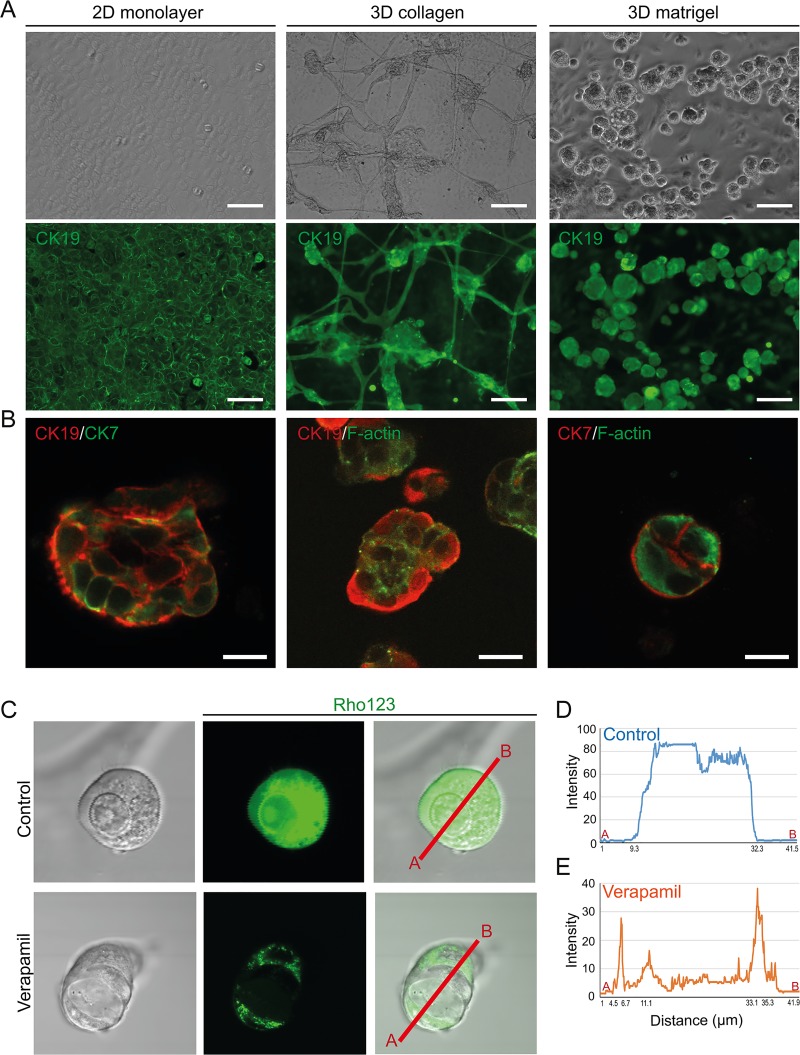
Characterization of iHepSC derived-cholangiocyte-like cells (iHepSC-CLCs).(A) Phase- contrast images of iHepSC-CLCs in different culture conditions (upper panel). Immunofluorescence images of iHepSC-CLCs stained with antibody against Cytokeratin19 (Ck19) (lower panel). Images of iHepSC-CLCs on 2D culture (left column). The tubule-like structure of iHepSC-CLCs cultured in the 3D collagen gel (middle column). The Cyst-like structure of iHepSC-CLCs cultured in the 3D Matrigel (right column). Scale bar: 150 μm. (B) Immunofluorescence analysis of iHepSC-CLCs co-stained with cholangiocyte specific markers, Ck19 and Cytokeratin7 (Ck7). Localization of F-actin (phalloidin) in the apical region of iHepSC-CLCs. The cells were counterstained with DAPI. Scale bar: 25 μm. (C) Transportation of rhodamine 123 (Rho 123) into the central lumen of the cyst (upper panel). The Mdr1 inhibitor, verapamil (10 μM), blocks Rho123 transportation (Lower panel). (D-E) Quantifications of the fluorescence intensity of Rho 123 in the cysts. The fluorescence intensity values along the A-B axis shown in (C) were measured using Olympus software and analyzed by image J.